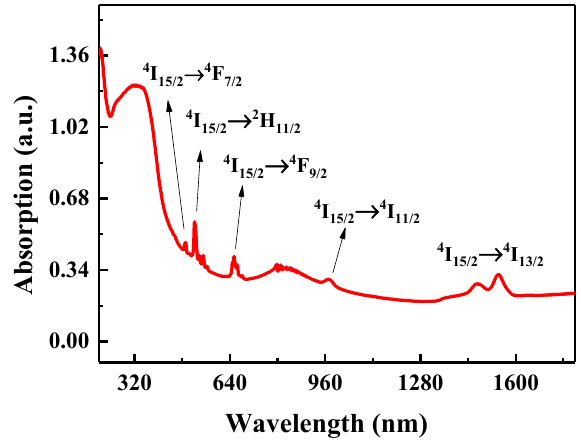
Figure 4. The optical absorption spectrum of the 15PEN–63PZN–22PT crystals.